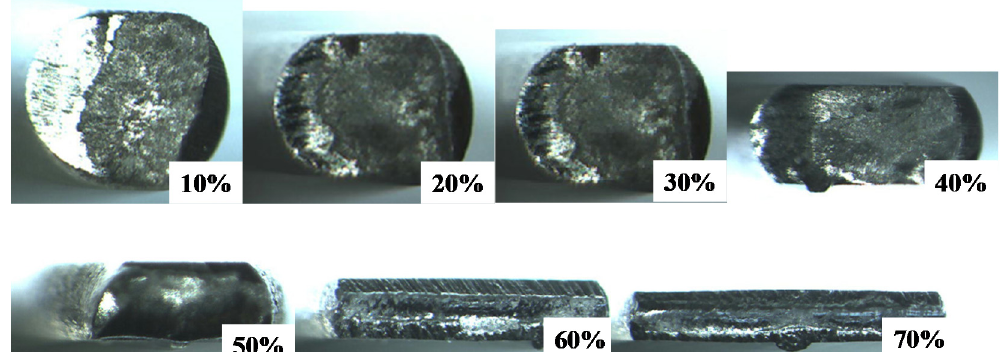
Figure 4. Variation of cross-sectional geometries from circular wire to flat plate with increasing the reduction in diameter.